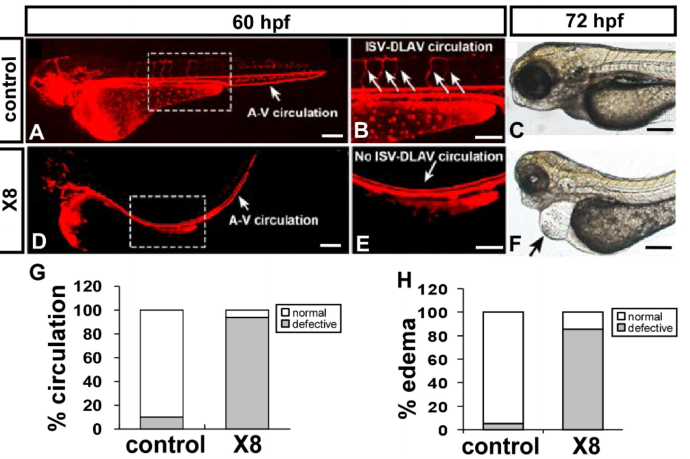
Figure 3. X8 treatment of embryos results in pericardial edema and circulatory defects. ( A , B , D , E ) X8-treated transgenic Tg(gata1:dsRed ) embryos at 60 hpf. X8-treated fish showed circulatory defects ( D , E ) compared with wild-type fish ( A , B ). ( G ) Circulatory defects at the ISV-DLAV part and slow to no axial circulation in the aorta/vein in the trunk region were quantitated in DMSO control (n = 24) and X8-treated embryos (n = 22) at 60 hpf. ( C , F ) A representative image of edema in a fish (arrow in ( F )) at 72 hpf is shown. ( H ) Quantitative analysis showed that 82% of X8-treated embryos (n = 20) exhibited mild–severe pericardial edema relative to control embryos (n = 21). Scale bars: 200 µ m in ( A , C , D , F ); 100 µ m in ( B , E